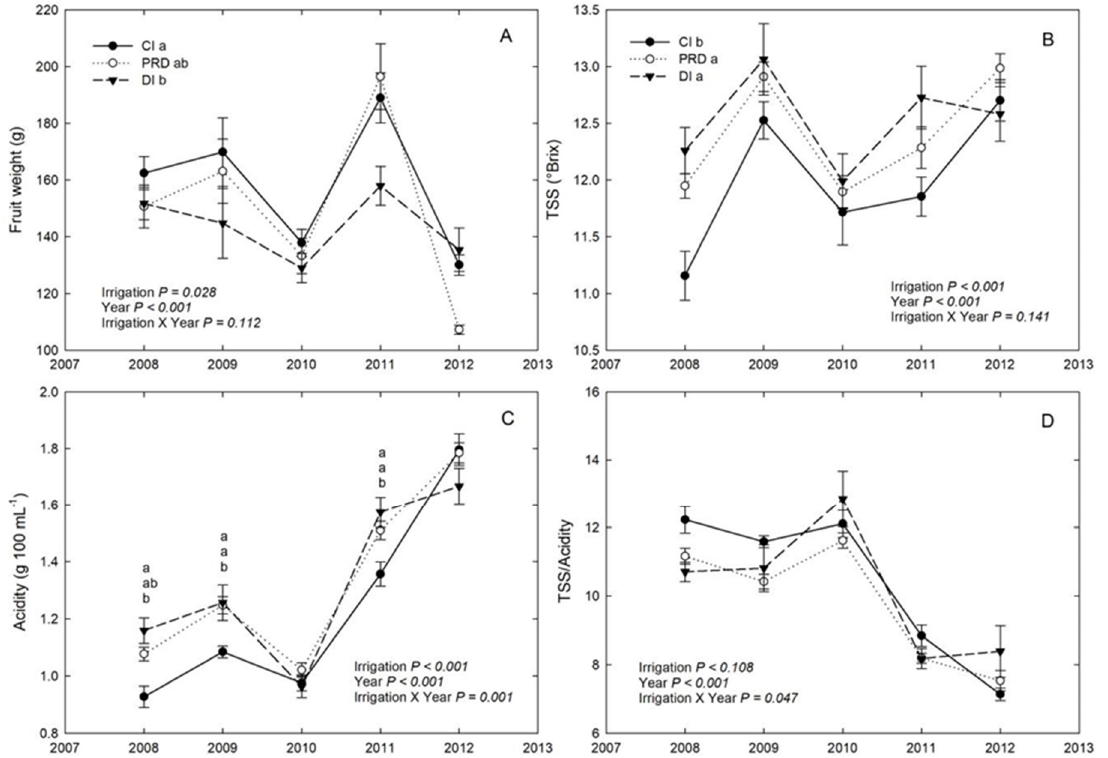
Figure 3. Fruit weight ( A ), total soluble solids (TSS, B ), acidity ( C ), and TSS to acidity ratio ( D ) in adult ‘Valencia’ orange trees under conventional irrigation (CI), partial rootzone drying (PRD), and continuous deficit irrigation (DI) in the five years of observations. Error bars are standard errors of the means. P-values in each panel are for main factors and interactions from the ANOVA models. When present, lower-case letters indicate significant differences among irrigation levels in a specific year (Tukey’s multiple range test, p < 0.05). Lower-case letters in panel A and B indicate significant differences among levels of irrigation (Tukey’s multiple range test, p < 0.05).